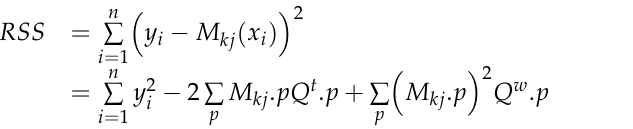
Stock Markets Return Series